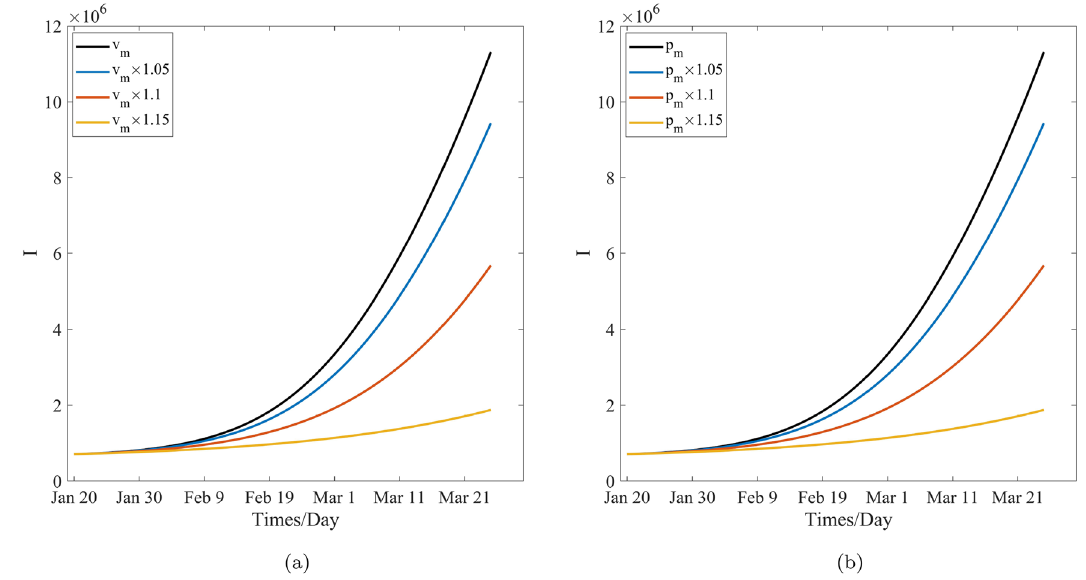
Figure 8. The effect of the critical parameters v m and p m on the cumulative